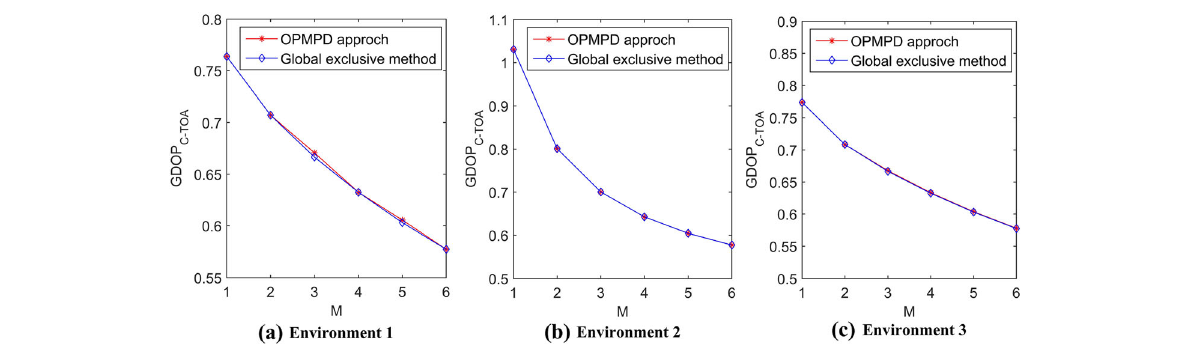
Fig. 8 Accuracy comparison of OPMPD approach and global exclusive method towards TOA-based system. a Environment 1. b Environment 2. c Environment 3